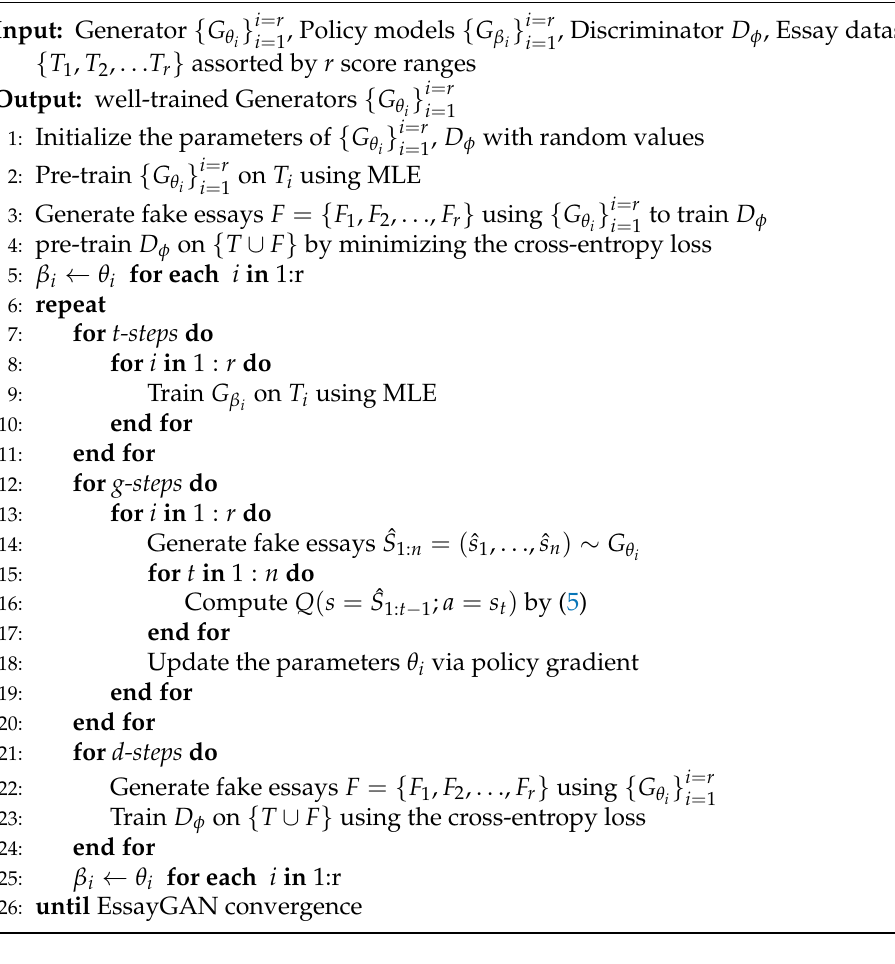
Algorithm 1 Training EssayGAN for essay data augmentation